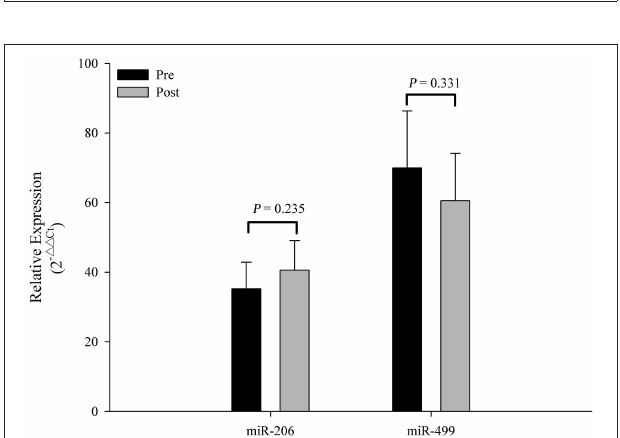
FIGURE 2 | The plasma miRNA levels in response to sprint interval cycling. Plasma levels of miR-1, miR-133a, miR-133b, miR-122, and miR-16 decreased significantly after an acute bout of sprint interval cycling. Values represent the mean ± SEM obtained from 18 subjects. ** P < 0.01 , *** P < 0.001 .